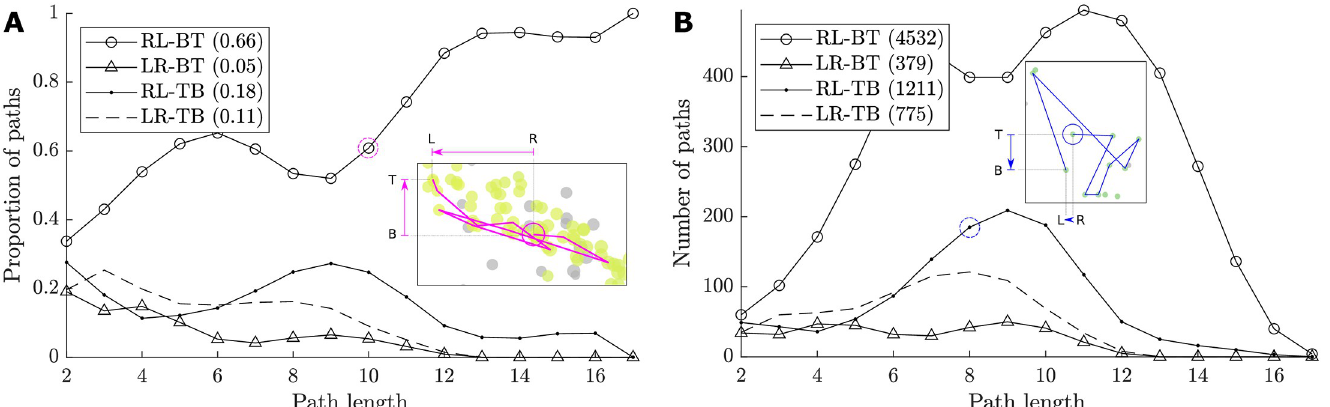
Fig 7. Evidence for an evolutionary drive within the STM population. The 1,020 edges in the genotype network yield 6,897 potential evolutionary paths. The subfigures show the proportion and number of paths evolving in a certain direction in the centrality-prevalence state space from Fig 3. This direction depends on the start and end-points of the path: right-to-left (RL), left-to-right (LR), top-to-bottom (TB), and bottom-to-top (BT). For instance, the first case study (magenta) is categorised as RL-BT (with ten edges), while the second case study (blue) follows the RL-TB direction (with eight edges). The absolute majority of paths (66%, or 4,532 paths) are shown to travel from the right-to-left (RL, decrease in centrality) and the bottom-to-top (BT, increase in prevalence), as shown in the figure legends. Further, the correlation between the path length and the change in prevalence is r = 0.497 ( M = 6,897, p < 0.00001). A: as the path length increases, a higher number of paths are associated with this dominant direction. B: a majority of these paths are within the range of 6–12 edges; the smaller set of longer paths (above 12 edges) all decrease in centrality, mostly capturing exploitative adaptation (RL-BT) with a minority attributed to unsuccessful exploration (RL-TB).